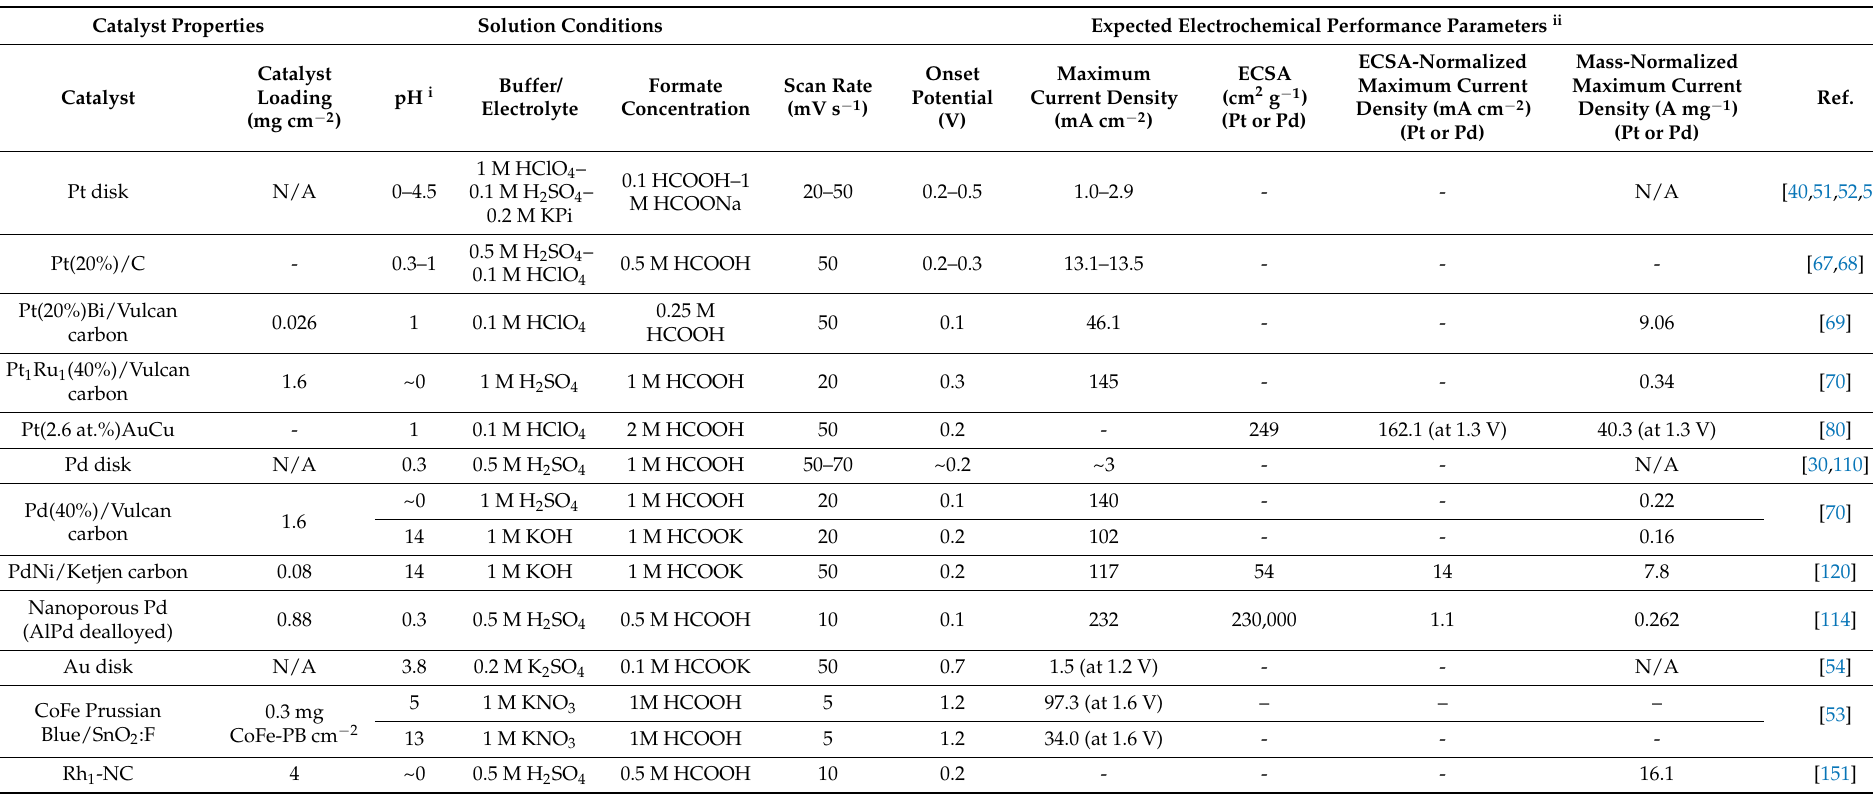
Table 5. Proposed benchmark systems and expected electrochemical performance for formate electrooxidation using some of the most promising